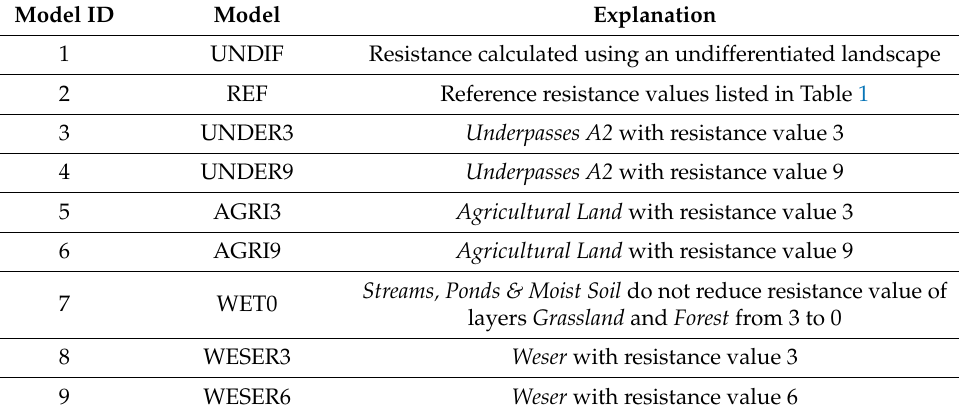
Table 2. Landscape resistance